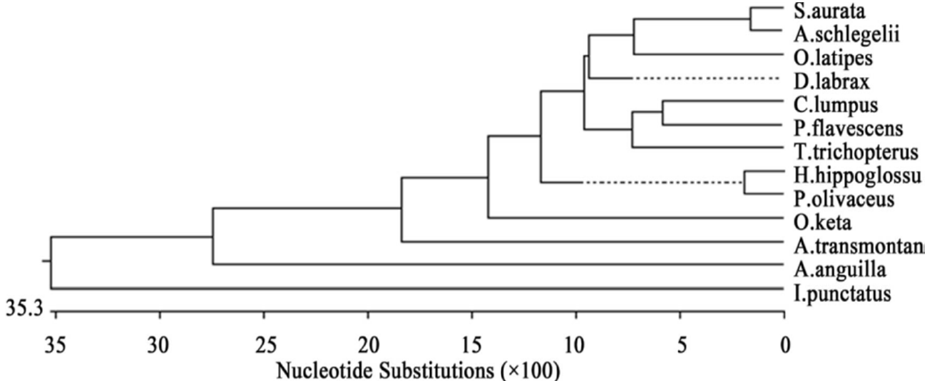
Figure 23. Phylogenetic tree showing the relationship between SL amino acid sequences from blue gourami and other fish species. The tree was generated by maximum Clustal W alignment and the MegAlign program (DNASTAR). All sequences were obtained from NCBI GenBank [44,45]. The highest degree of homology for SL was between T. trichopterus and the Perciform Perca flavescens and Cyclopterus lumpus . The lowest level of homology was observed with Anguilla anguilla . 7. Mitochondrial Cytochrome c Oxidase Subunit 1 (COI) Gene as a Variation Marker for Blue Gourami and Other Anabantoid Fishes COI is another genetic marker widely used to identify the kinship of fish species (Figures 24 and 25).